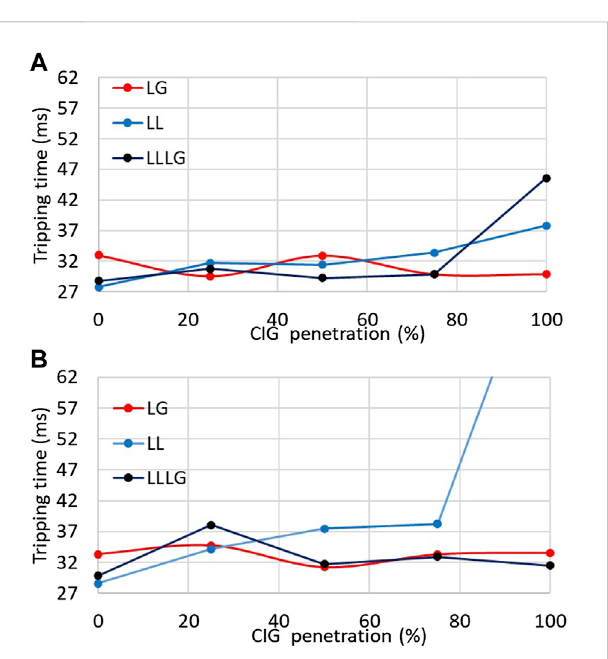
FIGURE 5 Protection tripping times using Unlimited grid-forming converter with respect to CIG penetration increase. (A) Tripping time on 10 km transmission line; (B) Tripping time on 200 km transmission line.